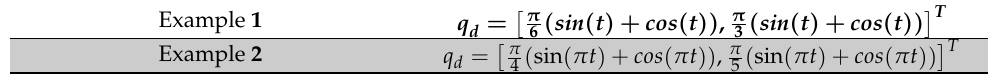
Table 4. Desired